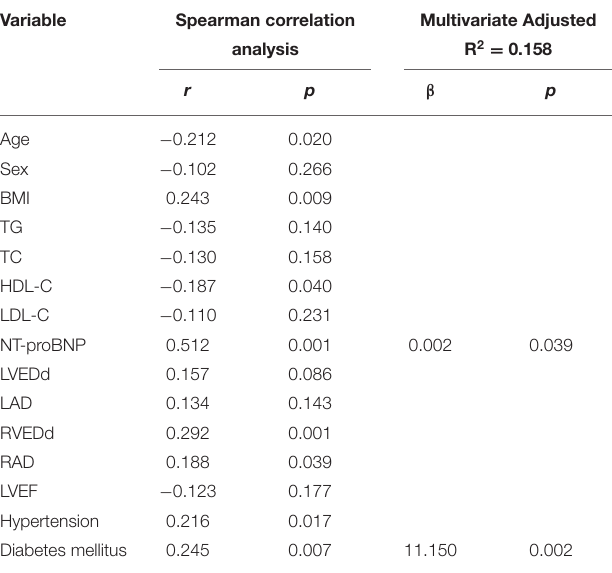
TABLE 2 | Spearman correlation and multiple linear regression analysis of the factors associated with AHI.